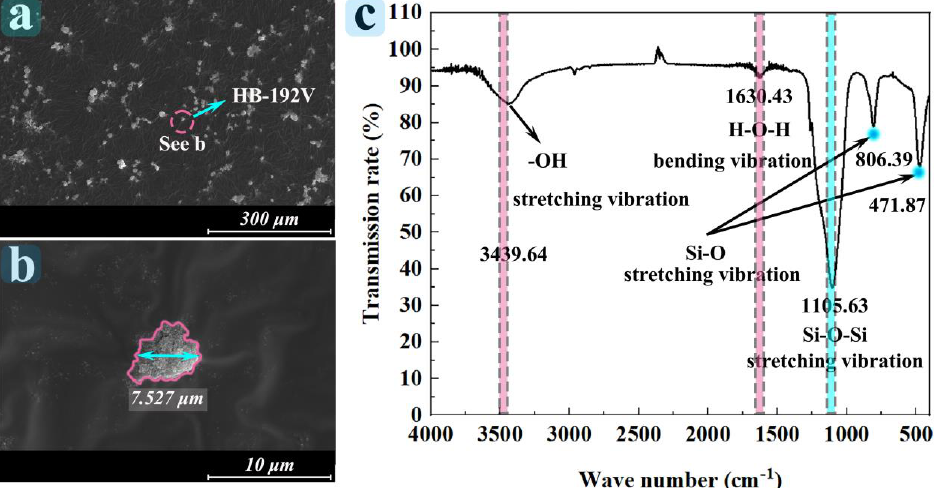
Figure 4. ( a ) Shows the macroscopic distribution of HB – 192V on conductive adhesive; ( b ) is a local magnification of the particles circled in Figure ( a ); ( c ) Fourier-transform infrared spectra of HB – 192V.